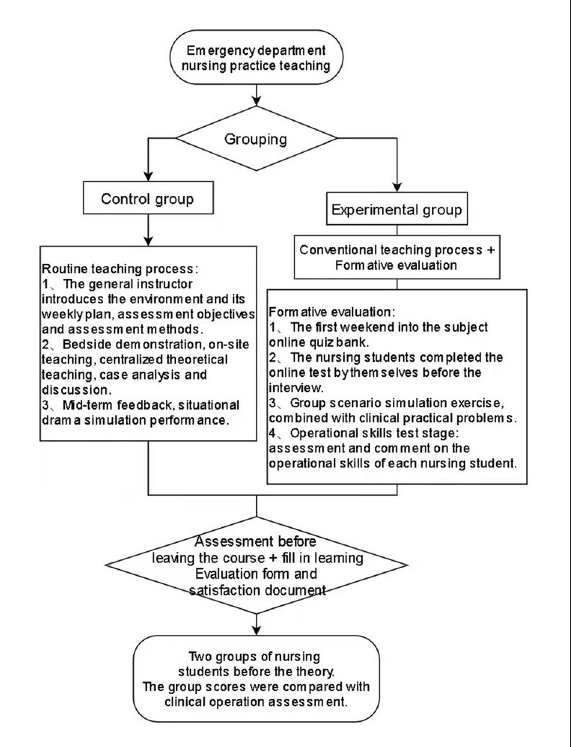
FIGURE1 Flow chart for mentoring evaluation during the nursing practice in the emergency department (the experiment group/the control